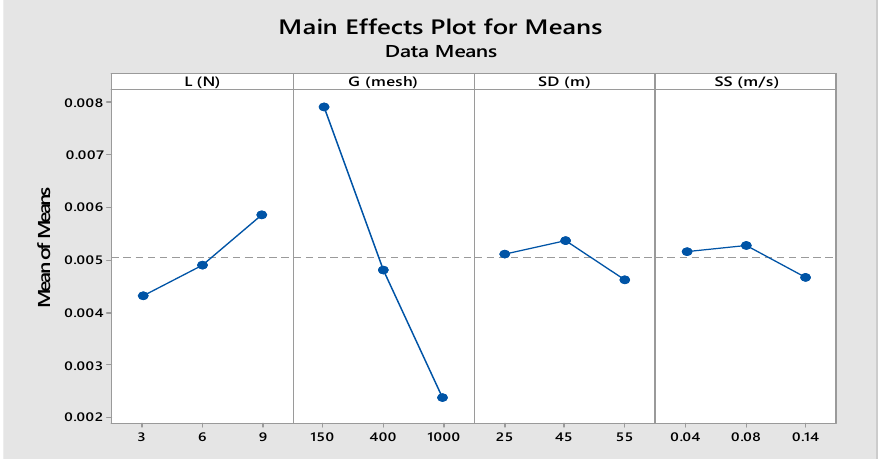
Figure 7. Main effect plot for mean mass loss of PTFE matrix composites.